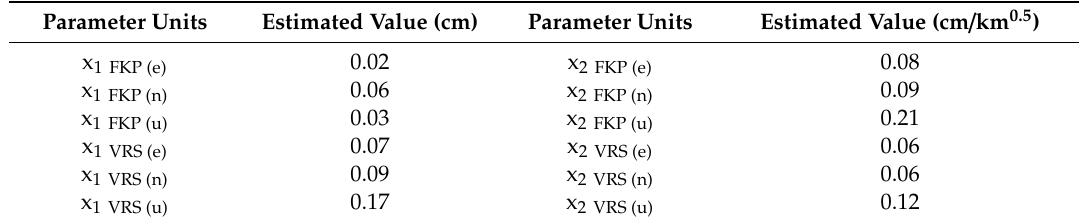
Table 3. Coe ffi cients of the empirical